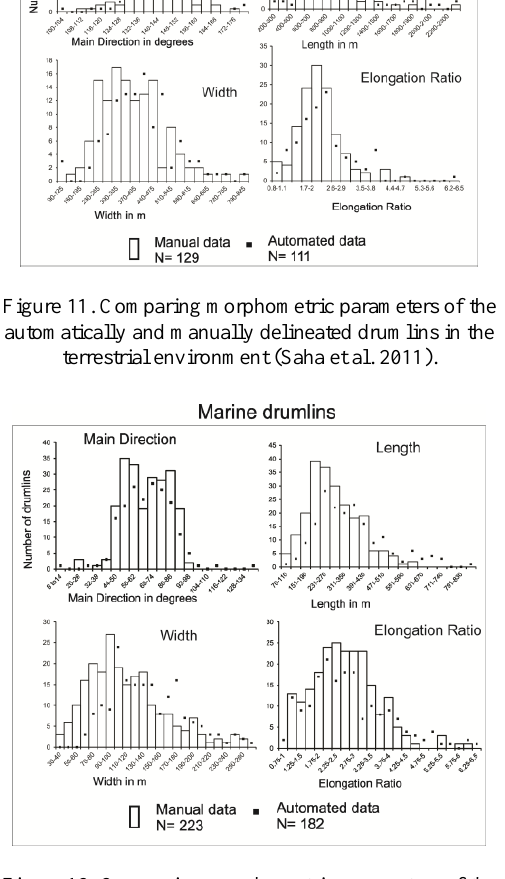
Figure 12. Comparing morphometric parameters of the automatically and manually delineated drumlins in the marine